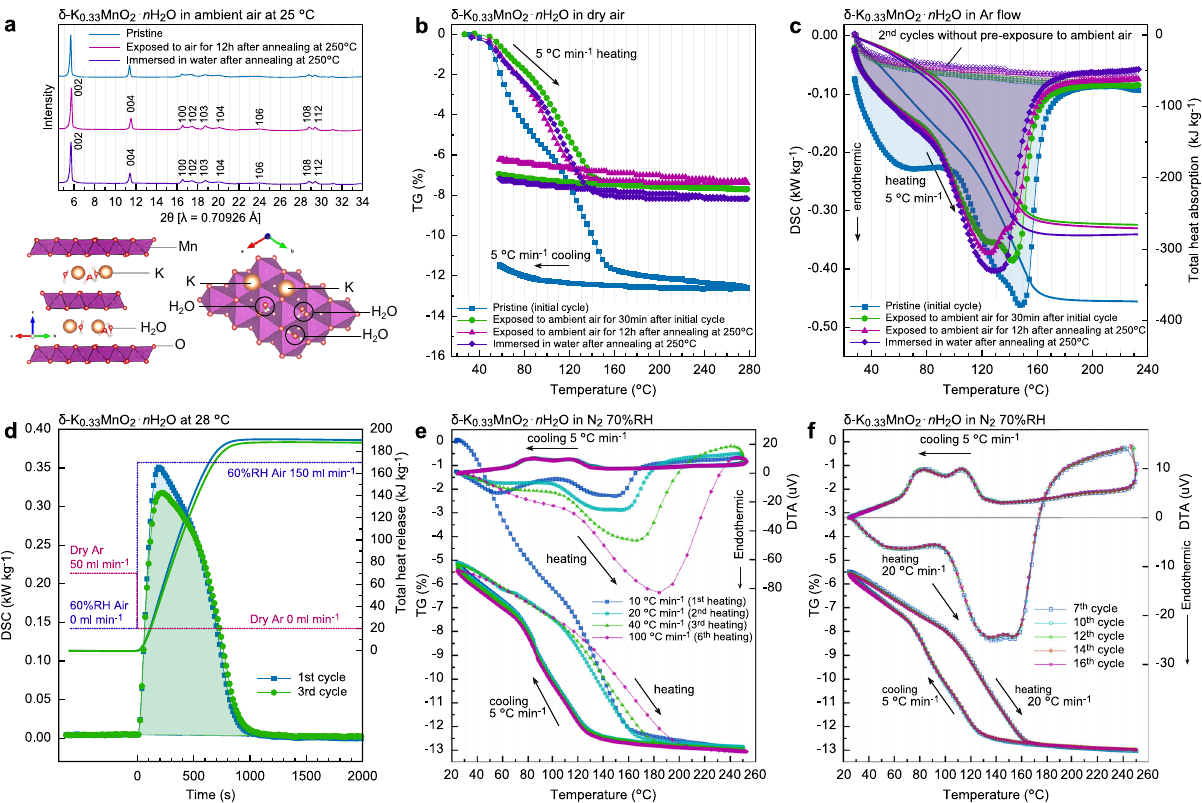
Fig. 1 Structure and thermal properties of K 0.33 MnO 2 n H 2 O. a X-ray diffraction pro fi les for pristine sample, sample after annealed at 250 °C and then exposed to ambient air for 12 h, and sample after annealed at 250°C followed by immersion into water. In the lower fi gure, the layered structure of δ -MnO 2 is also shown, where the possible sites for K + and H 2 O in space group #194: P 6 3 / mmc are indicated in the structure. b TG (weight change) pro fi le for samples of (light blue) pristine, (green) exposed to ambient air (60% relative humidity (RH) at 22 °C) for 30 min after initial cycle, (magenta, purple) exposed to ambient air for 12 h or immersed in water after annealed at 250 °C. The reference point (i.e., zero point) in TG is given with respect to the beginning of each TG measurement. c DSC pro fi les during heating (charge). The samples correspond to the respective TG measurements. d Isothermal DSC pro fi les at 28 °C while being exposed to ambient air with 60%RH moisture (discharge). e TG-DTA pro fi les in a N 2 -gas atmosphere with 70%RH moisture at 25 °C (2.2%H 2 O in N 2 gas) at various heating rates (10 – 100 °C min − 1 ). f TG-DTA cycle measurement in 2%H 2 O-N 2 at heating 20 °C min − 1 and at cooling 5 °C min − 1